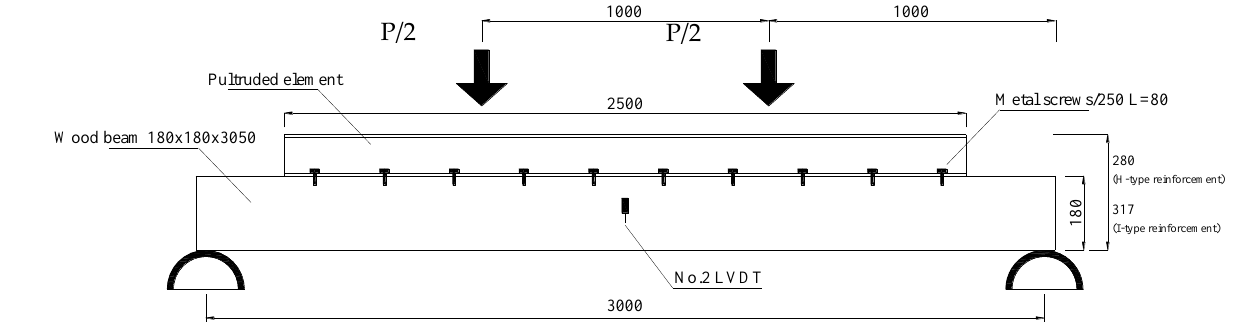
Figure 5. Test layout.